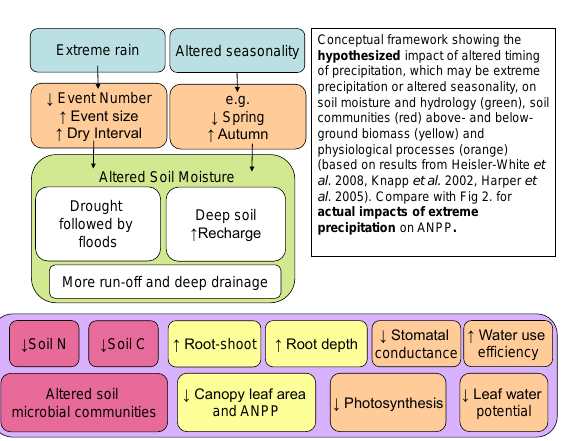
Figure 3. Conceptual framework showing the possible impacts of extreme and seasonal precipitation on soil and plant processes. Based upon Heisler-White et al., 2008; Knapp et al., 2002, and Harper et al., 2005. The bottom panel, purple, shows plant and soil responses when the overall response to extreme precipitation is a decrease in soil water content. Arrow directions will be reversed when the overall response to extreme precipitation is an increase in soil